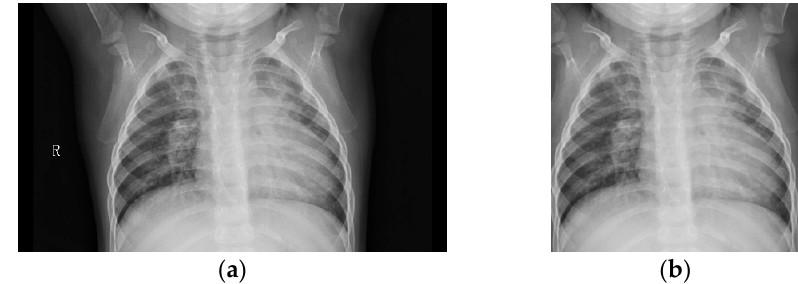
Figure 7. Preprocessing technique used in the Pneumonia dataset for all the examples. ( a ) The original image of a person with pneumonia (https://data.mendeley.com/datasets/rscbjbr9sj/2); ( b ) the preprocessed image with the final dimension of 299 × 299 pixels.